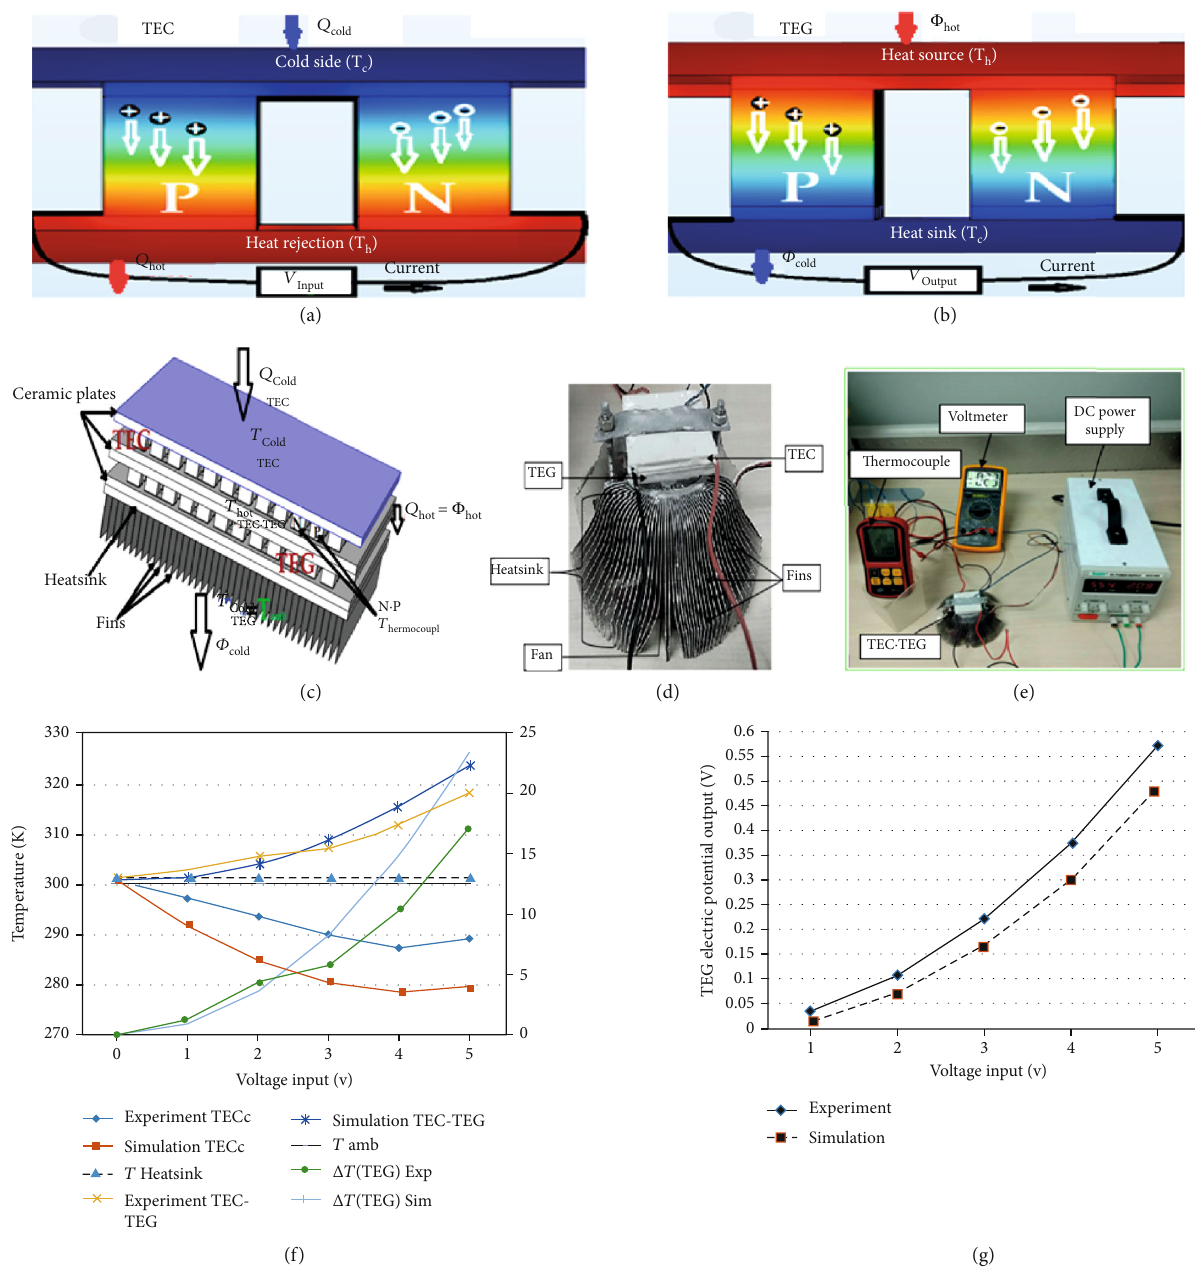
Figure 9: Summary of the simulated model and experimented TEC-TEG (adapted from